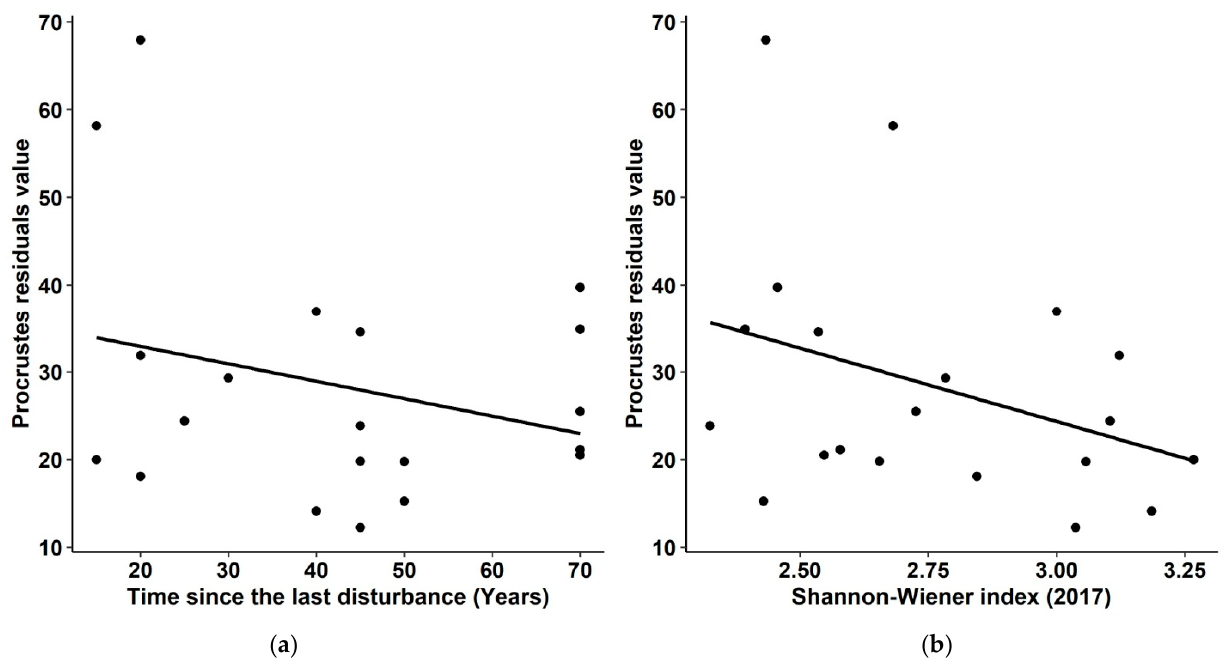
Figure 2. Results of the multiple linear regression analysis between the stand-centered Procrustes residual values representing the magnitude of changes in occurrence for species with the largest gains between 2003 and 2017 ( N = 24) and the two explanatory variables revealed by multimodel selection (Q2), i.e., ( a ) the time since the last disturbance (Age) and ( b ) the Shannon–Wiener index of the understory plant community in 2017 (H ′ 17). The fitted regression model lines (Age: y = 129.3 − 0.42x; H ′ 17: y = 129.3 − 30.1x) are shown for each explanatory variable. Table 6. Comparison of average values and standard deviation (SD) of the relative proportion in stand total occurrences (% AVG ), for shade tolerant exotics (Q3) and sensitive spring geophytes (Q4) between the 2003 and 2017 understory communities inventories ( N = 20). Statistics of the Wilcoxon paired t -test (direction of changes and associated p -value) are also included, as well as the number of species (N Sp ) in each group and their relative proportion in the total vegetation across stands (i.e., all 20 study sites combined; % TOT ) for both years (see Tables S2/S3 for species list).